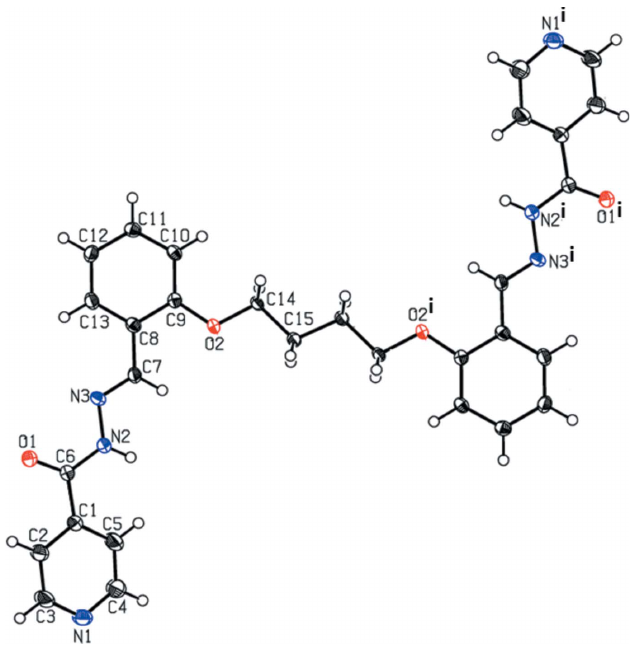
Figure 2 View of the molecular structure of compound (II), with the atom labelling. Displacement ellipsoids are drawn at the 50% probability level. Unlabelled atoms are related to labelled atoms by inversion symmetry [symmetry code (i): (cid:5) x , (cid:5) y + 1, (cid:5) z